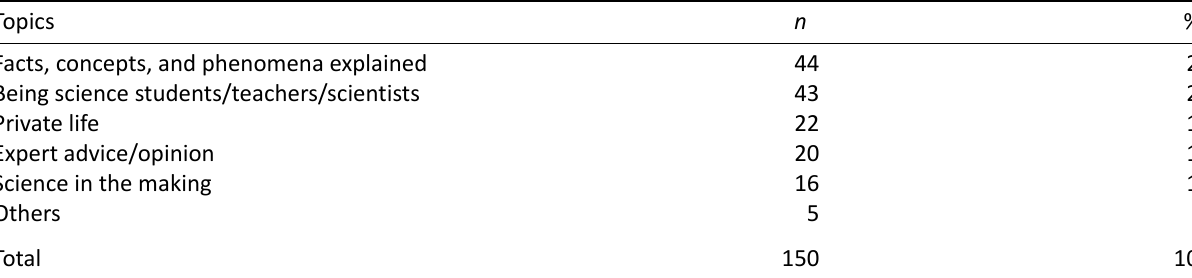
Table 3. Topics of the TikTok videos